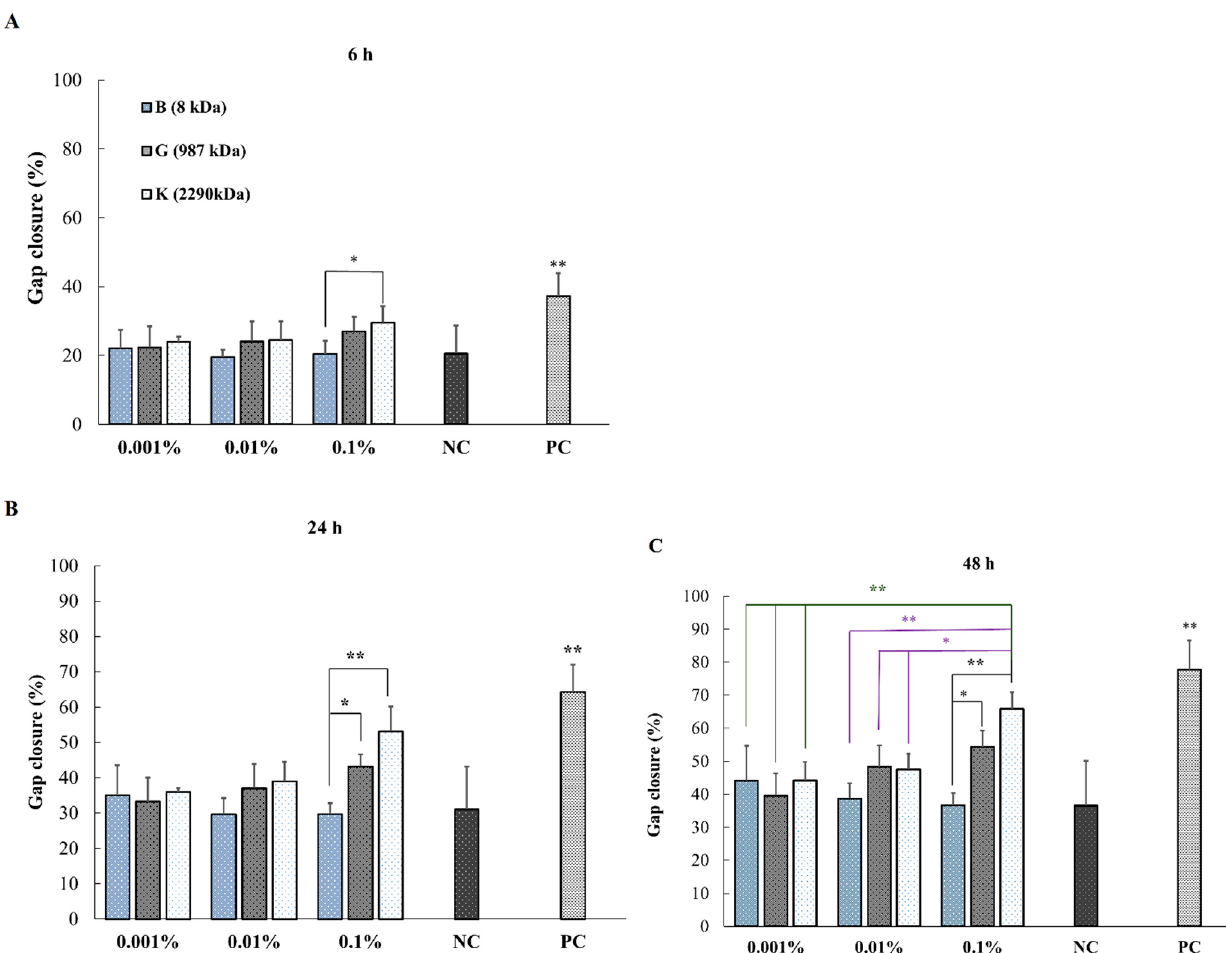
Figure 5. Representation of in vitro wound closure of HaCaT cells at time 6 h ( A ), 24 h ( B ) and 48 h ( C ) upon addition of 0.001, 0.01 and 0.1% HA with three MWs. Data are expressed as wound closure percentage of wound scratch area relative to initial scratch area (mean ± SEM, n = 5, * p < 0.05, ** p < 0.01).